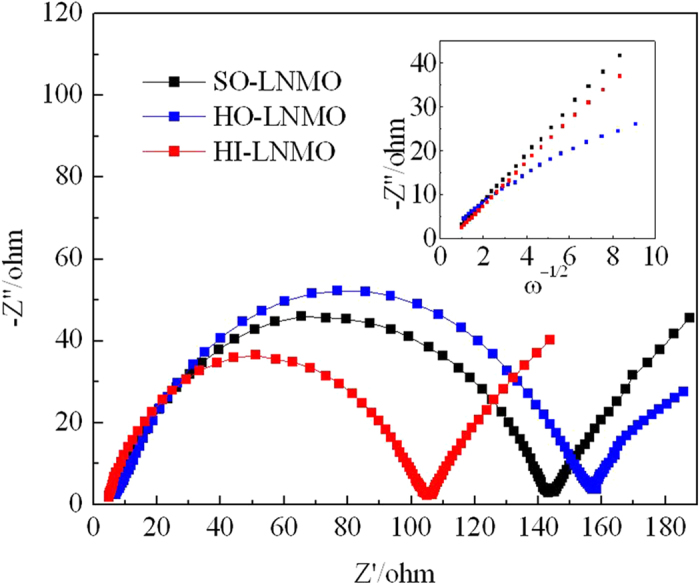
Electrochemical impendence spectroscope of LiNi0.5Mn1.5O4 with different microstructures.